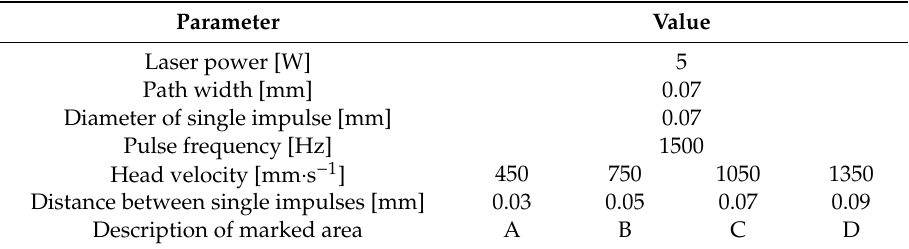
Table 4. Laser marking parameters used to prepare the